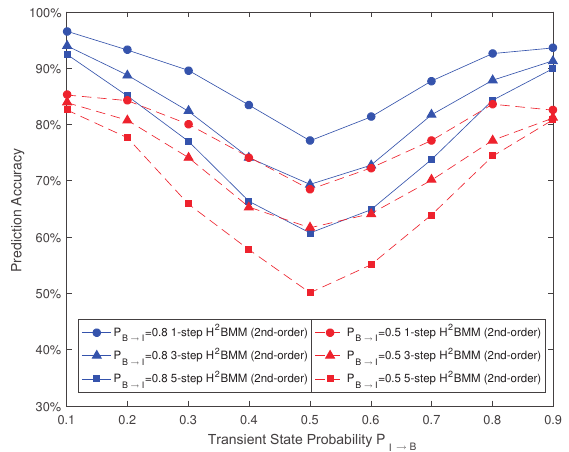
Figure 6. Prediction accuracy of H 2 BMM (2nd-order) when P B → I is 0 . 8 and 0 . 5